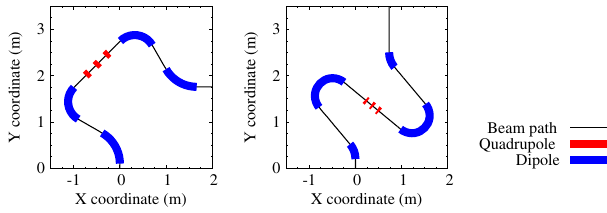
FIG. 3. Basic layout examples of 3 π (left) and 4 π (right) bunch compressors. Beam enters at (0,